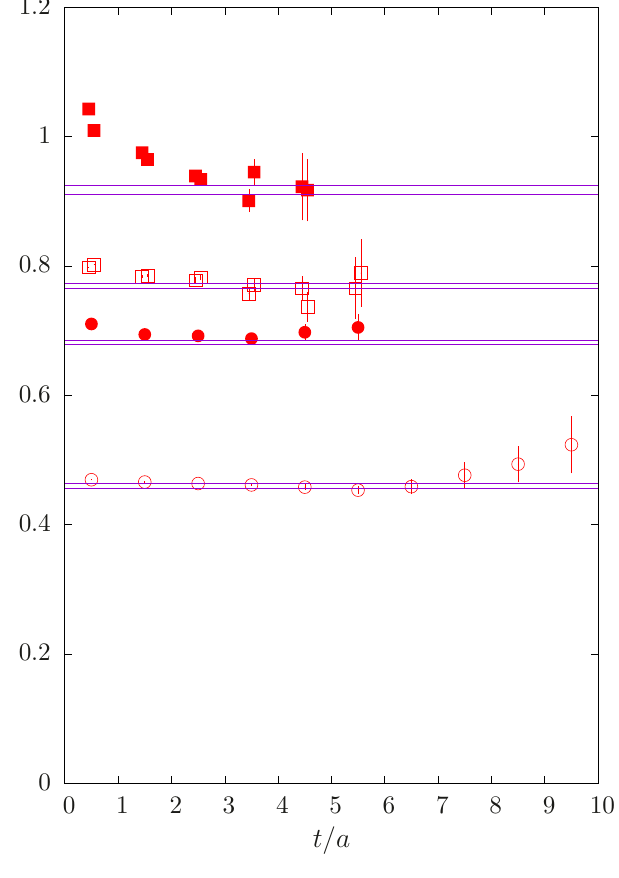
Figure 2 . E(cid:11)ective energies of the lightest glueballs in SO(6) at (cid:12) = 46 : 0 on a 46 2 48 lattice: trace J P = 0 + , and trace 2 (cid:6) , (cid:3) with Pfa(cid:14)an ‘0 + ’, (cid:14) for the J PC = 0 ++ , 0 (cid:0)(cid:0) , 2 (cid:6) + , 2 (cid:6)(cid:0) masses (in ascending order) obtained in SU(4) at (cid:12) = 59 : 14 on the same size